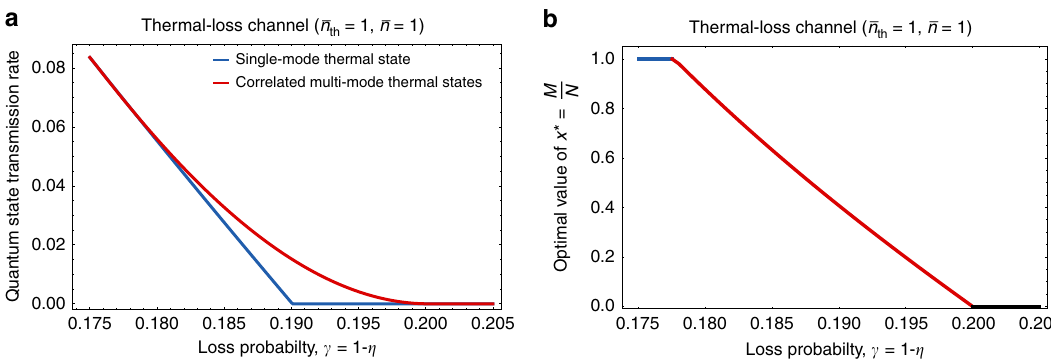
1 (cid:2) as th ¼ (cid:2) n ; 0 Þ . b The optimal value of x ? xI η ; (cid:2) n ; ^ τ ð (cid:2) n = x ÞÞ , where N = ( M , N − M ) and n ¼ ð N M 0 < x (cid:7) 1 c ðN½ th (cid:2)